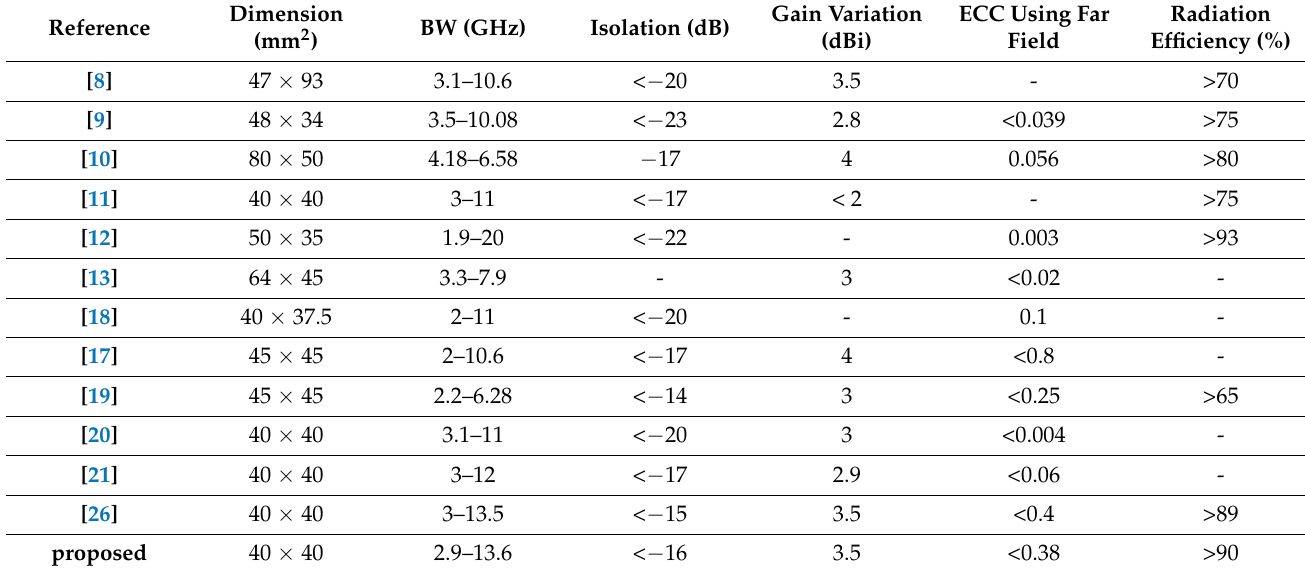
Table 1. The comparison of the proposed UWB MIMO antenna with state-of-the-art antennas.